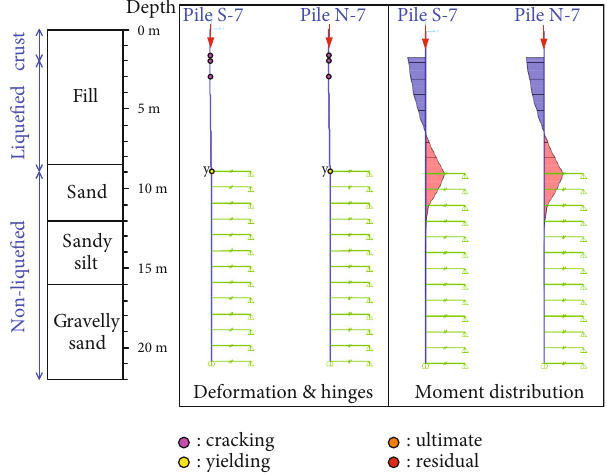
Figure 11: Deformation, plastic hinges, and moment distribution along the piles (lateral spreading as fl ow pressure, with axial load) at yielding state (ultimate and fi nal states not